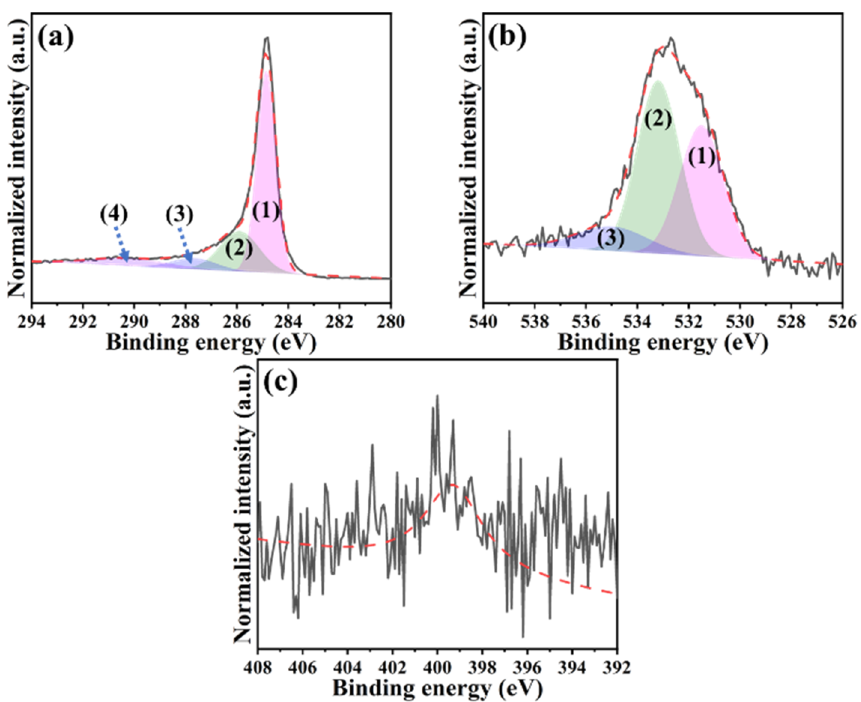
Figure 5. High-resolution XPS spectra of H@H composite material: ( a ) C 1s ((1) for C=C, (2) for C − O, (3) for C=O, and (4) for O=C − O bonds), ( b ) O 1s ((1) O=C − O, (2) C=O, and (3) C − O bonds), and ( c ) N 1s.